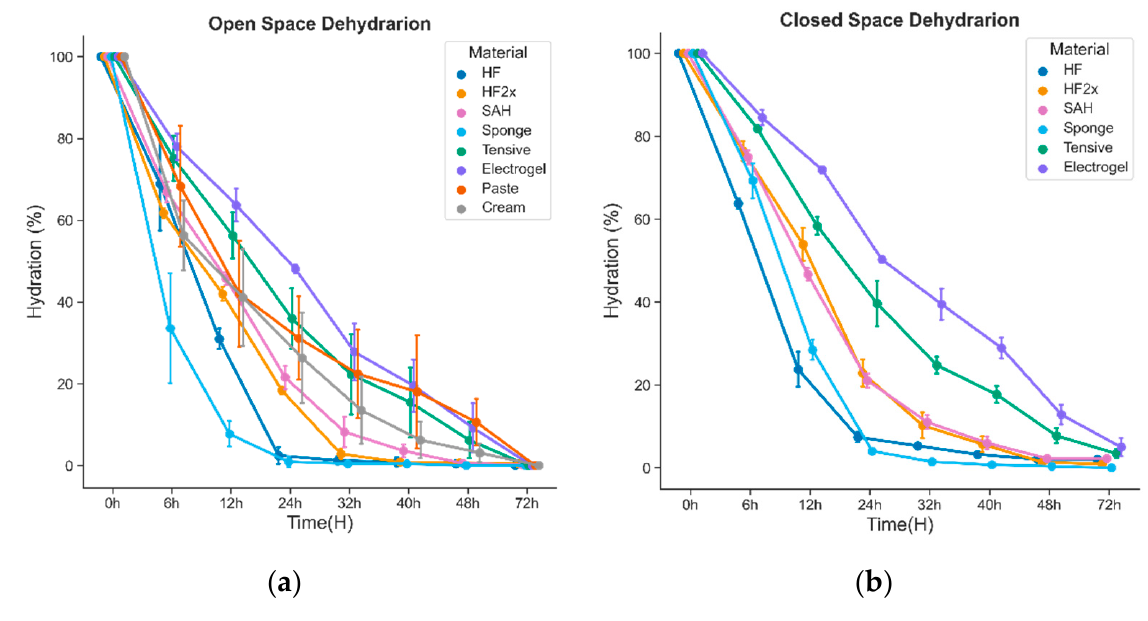
Figure 5. Results of dehydration tests for different types of conductive materials are shown separately for ( a ) the open space and ( b ) the closed space situation. The results are shown as loss of water, i.e., drop of weight as a function of time. The error bars (SEM) depict the results from n = 3 experiments.